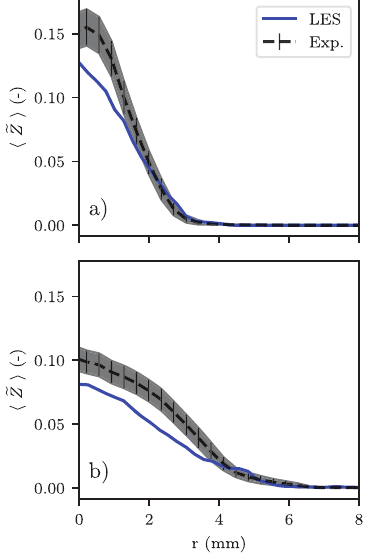
Fig. 6. Averaged radial mixture fraction distribution obtained from Raman measurements [52] (black curve) and LES (blue curve) at 17.5 mm (a) and 30 mm (b) downstream the nozzle ori fi